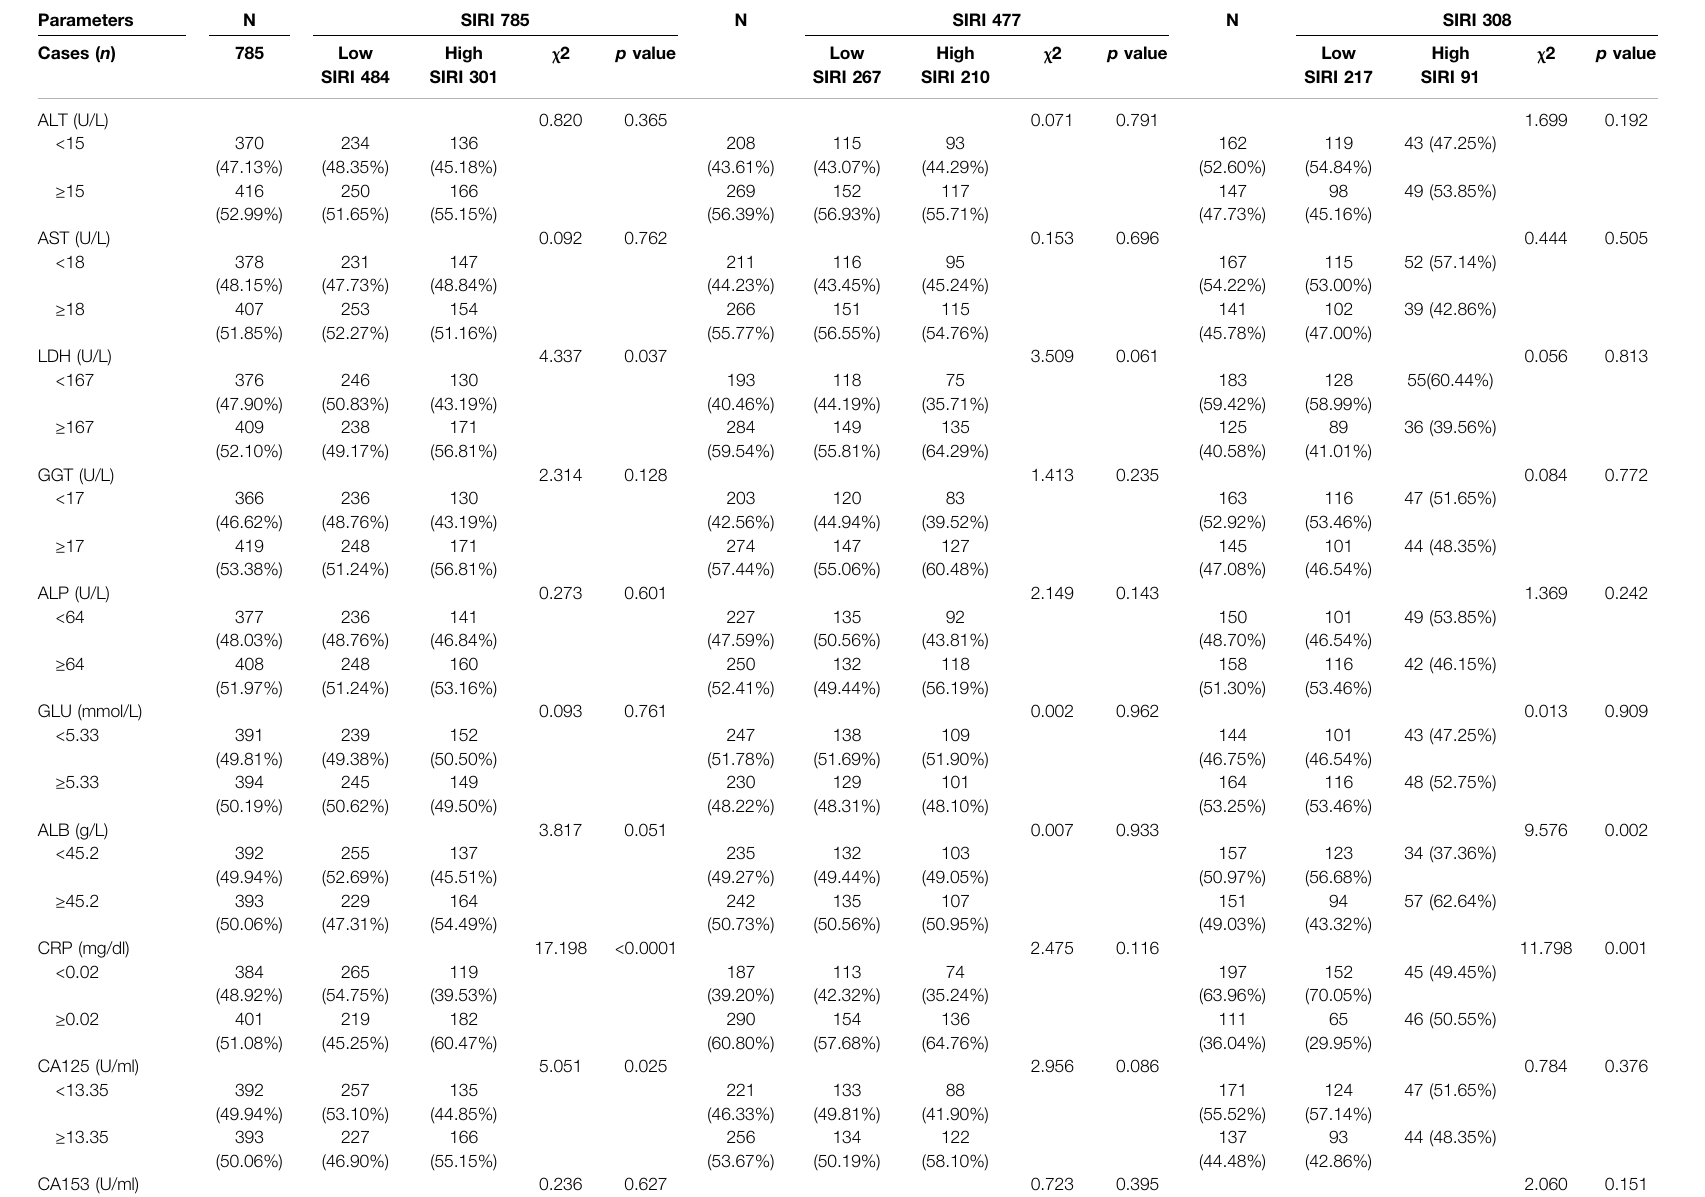
TABLE 2 | The correlations between nutritional parameters/blood parameters and